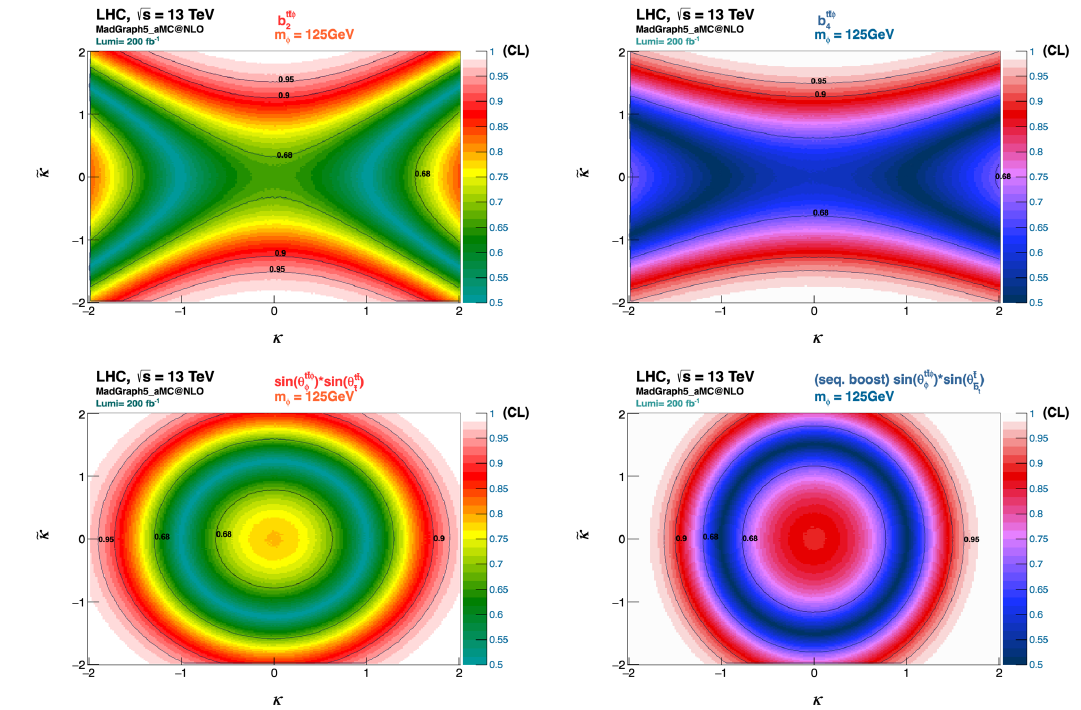
Figure 6 . CLs for the exclusion of the SM with a 125 GeV Higgs boson φ with mixed scalar and pseudo-scalar couplings (CP-mixed case), against the SM as null hypothesis. Limits are shown for a luminosity corresponding to the full RUN 2 data and first year of RUN 3 i.e., L =200 fb − 1 .